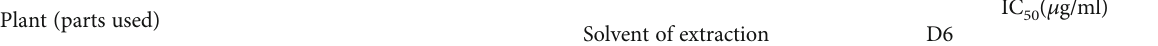
Solvent of extraction